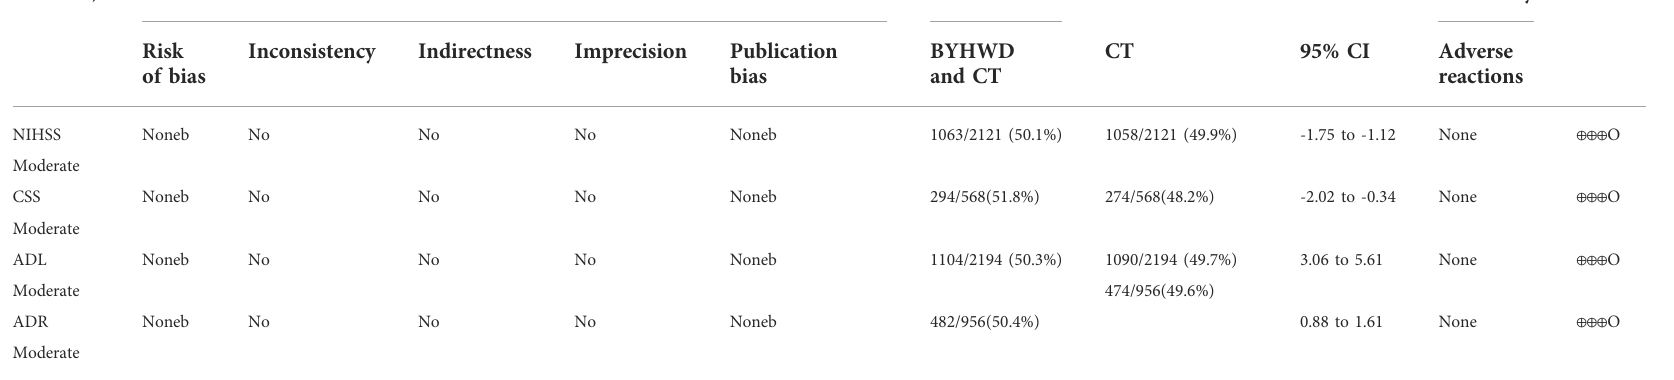
TABLE 6 Evidence GRADE pro fi le. Outcome (no. Of